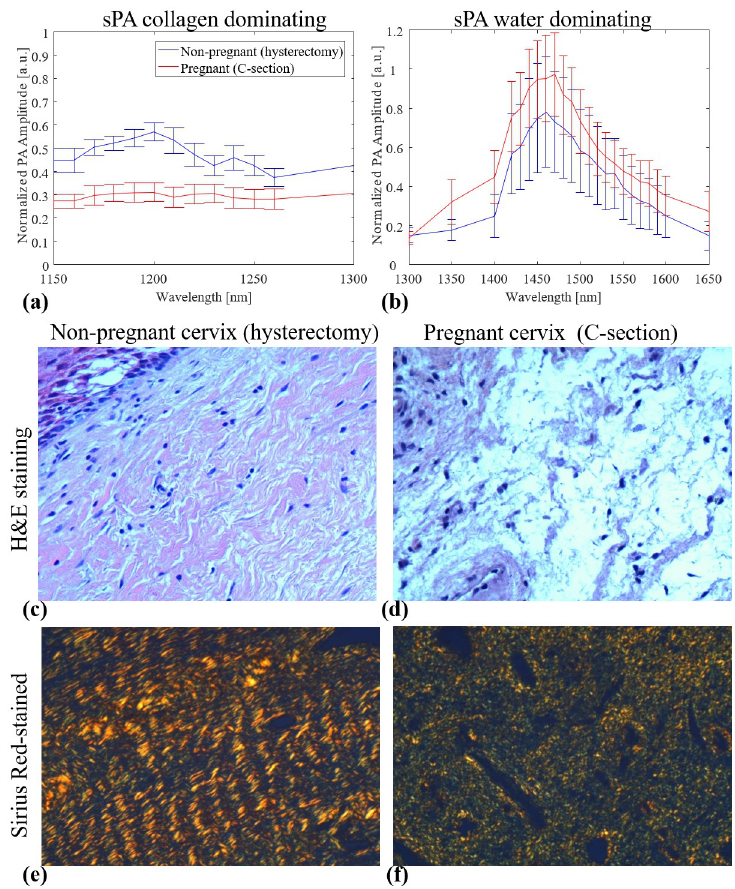
Fig 3. Averaged PA signal amplitudes and histological images of non-pregnant and pregnant women. (a, b) Spectroscopic photoacoustic (sPA) imaging signals of cervix samples obtained from pregnant and non-pregnant women (n = 8 for each group). The cervix samples from non-pregnant women showed higher PA signal amplitudes in the collagen absorption peak (around 1200 nm). By contrast, the cervix samples from pregnant women presented higher PA signal amplitudes in water absorption peak (around 1470 nm). (c, d) H&E-stained images indicated the loss of tissue composition (uncolored space) in non-pregnant cervix samples compare to pregnant cervix samples. (e, f) Sirius Red-stained images of non-pregnant and pregnant tissue visualized by polarized light microscope. The latter revealed less packed collagen fibers (red/yellow rod-like structure). averaged sPA amplitude changes across eight cervical tissue samples in each group along wave- lengths, histological H&E staining, and Sirius Red-stained images of non-pregnant and preg- nant women. From the detected PA signal amplitudes (Fig 3a and 3b), the non-pregnant cervical tissues had a clear peak from collagen absorptions in the collagen-dominating range (1150 to 1250 nm). By contrast, in the water-dominating range (1300 to 1650 nm), the cervical tissues from pregnant women had higher PA amplitude. H&E microscopic images (Fig 3c) of cervix samples taken from non-pregnant humans showed compact collagen bundles with min- imal or no intervening edema. When examined with Sirius Red stain, it was evident that the collagen fibers form bundles with distinct fasciculation (Fig 3e). By contrast, the cervical sam- ples from pregnant women showed loose collagen fibers with no discrete bundles and the pres- ence of water (edema) separating the collagen fibers (Fig 3d). The absence of discrete collagen bundles, as well as the loss of the distinct fasciculation seen in samples from non-pregnant women, was evident (Fig 3f). We further quantified the CWR with the sPA wavelength